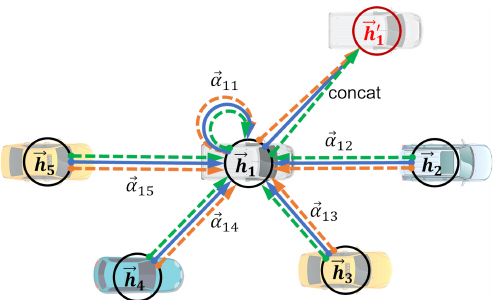
Figure 4. An illustration of multi-head attention with a single graph attention